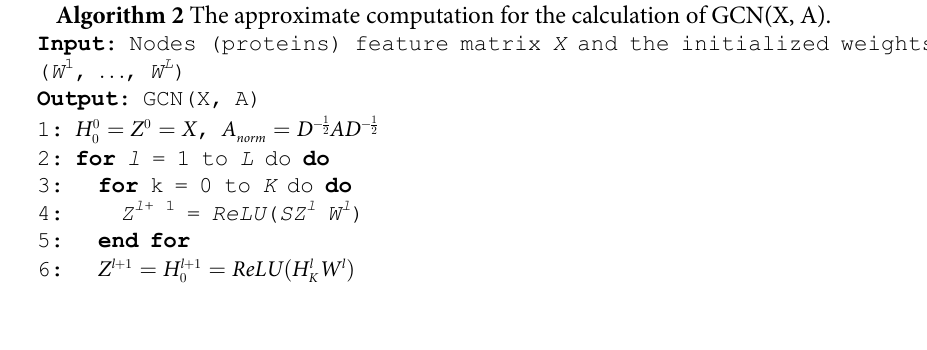
Algorithm 2 The approximate computation for the calculation of GCN(X,